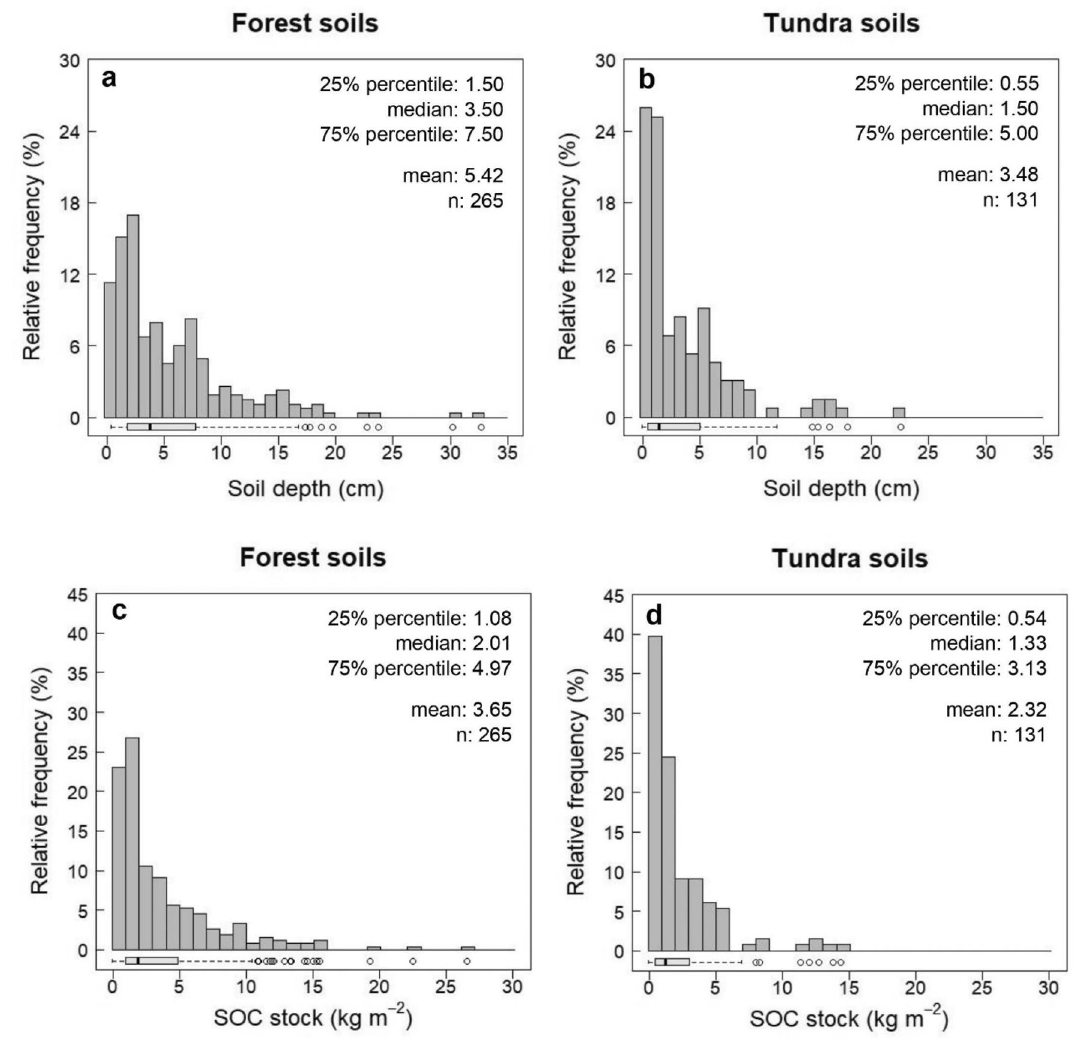
Figure 2. Soil depths and soil organic carbon (SOC) stocks of surface soils across 14 treeline ecotones in northern Norway. Soil depths of forests at treeline ( a ), soil depths of tundra above the treeline ( b ), SOC stocks of forests at treeline ( c ), SOC stocks of tundra above the treeline ( d